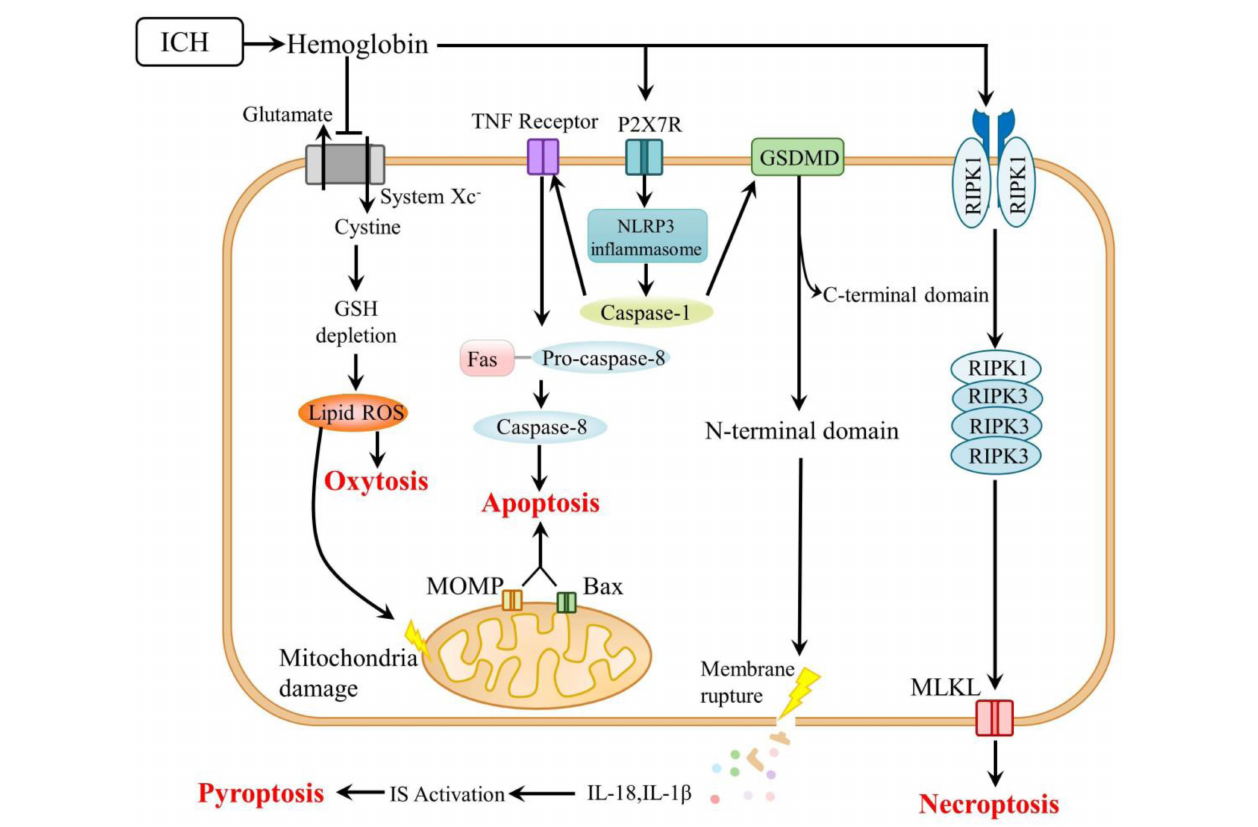
FIGURE 2 | Mechanisms of other types of cell death after ICH. ICH, intracerebral hemorrhage; GSH, glutathione; ROS, reactive oxygen species; TNF, tumor necrosis factor; MOMP, mitochondrial outer membrane permeabilization; P2X7R, P2X7 receptor; NLRP3, nucleotide-binding oligomerization domain-like receptor 3; GSDMD, gasdermin D; RIPK, receptor-interacting protein kinase; MLKL, mixed lineage kinase domain-like; and IS, immune